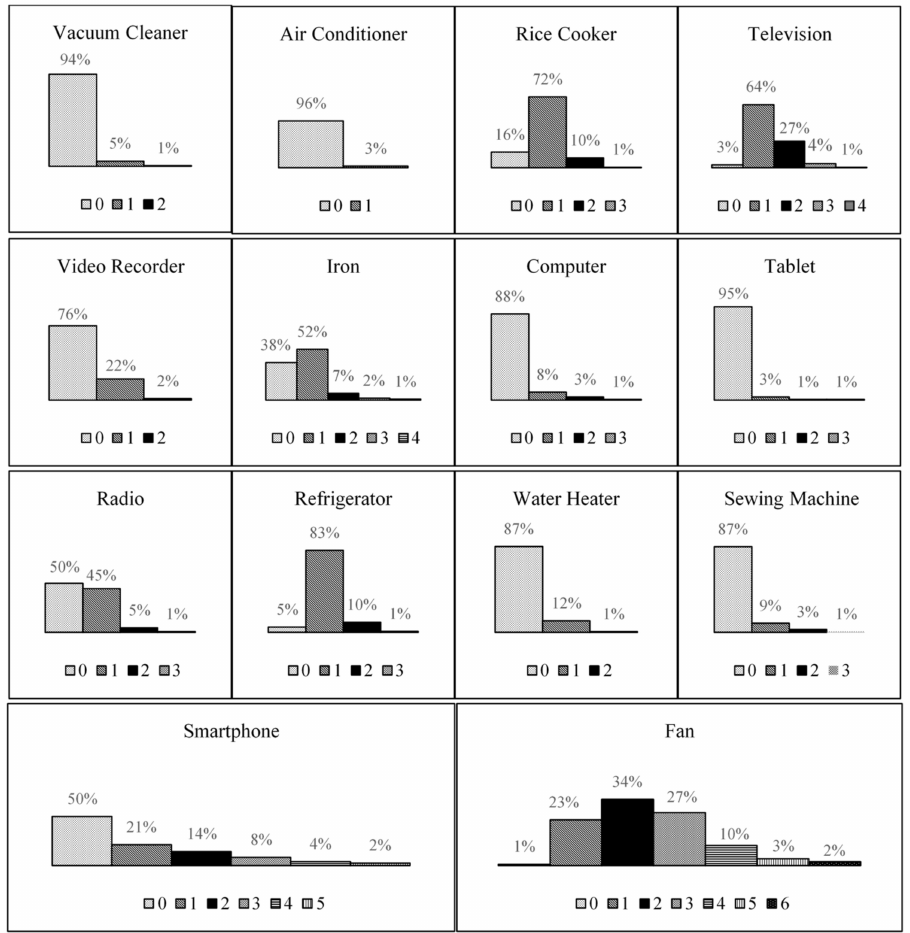
Figure 2. Distribution of the number of appliances owned in the rural households of Nakhon Phanom in 2017 based on the TVSEP